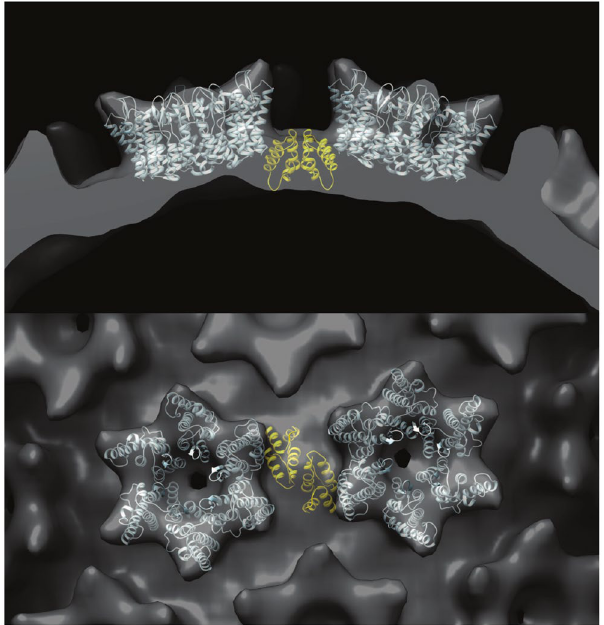
Figure 9. An illustrative molecular model, showing the connection between neighboring hexamers in the RSV CA-SP tube. NTD hexamers (light blue) were fitted into the 3D reconstruction using real space rigid body refinement with Phenix 111 . A CTD dimer (Gold) was positioned underneath, in a position consistent with the the inferred interaction 20 between Ala 64 (NTD) and Asn 169 (CTD).The views displayed are parallel (top) and perpendicular (bottom) to the helix axis. Coordinates for the NTD hexamer and CTD dimer were taken from the pseudo-atomic model of the planar hexamer array (PDB ID: